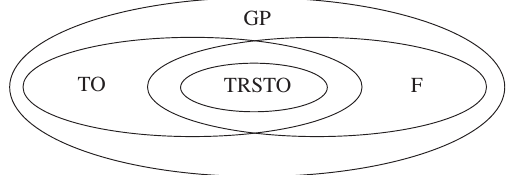
FIG. 15. Classes of channels. Schematic description of the relation between the time-reversal-symmetric thermal operations (TRSTO), the thermal operations (TO), the Gibbs preserving maps (GP), and the set of channels (F) that satisfy the fluctuation relation (L1), for a given β , H , and T such that T ð H Þ ¼ H . We know from Sec. VII A that F ⊇ TRSTO, and it is clear from the definitions that TO ⊇ TRSTO. Moreover, GP ⊇ TO [130]. In Lemma 20, it is shown that GP ⊇ F. For specific choices of β , H , and T , we moreover find explicit examples of channels in the sets TO\F, F\TO, and GP nð TO ∪ F Þ ; i.e., there are cases where these sets are nonempty. The drawing suggests that ð TO ∩ F Þn TRSTO would be nonempty. However, it is not clear whether this is the case or not. In Appendix L 1 d, it is shown that TRSTO is convex. The set TO is also convex [35], and one can realize that GP and F are